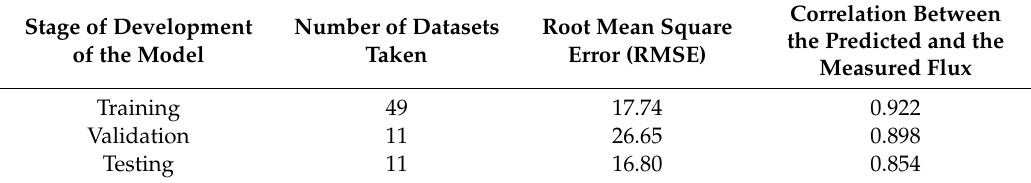
Table 3. Performance of the ANN model for predicting CH 4 emissions, during the training and testing